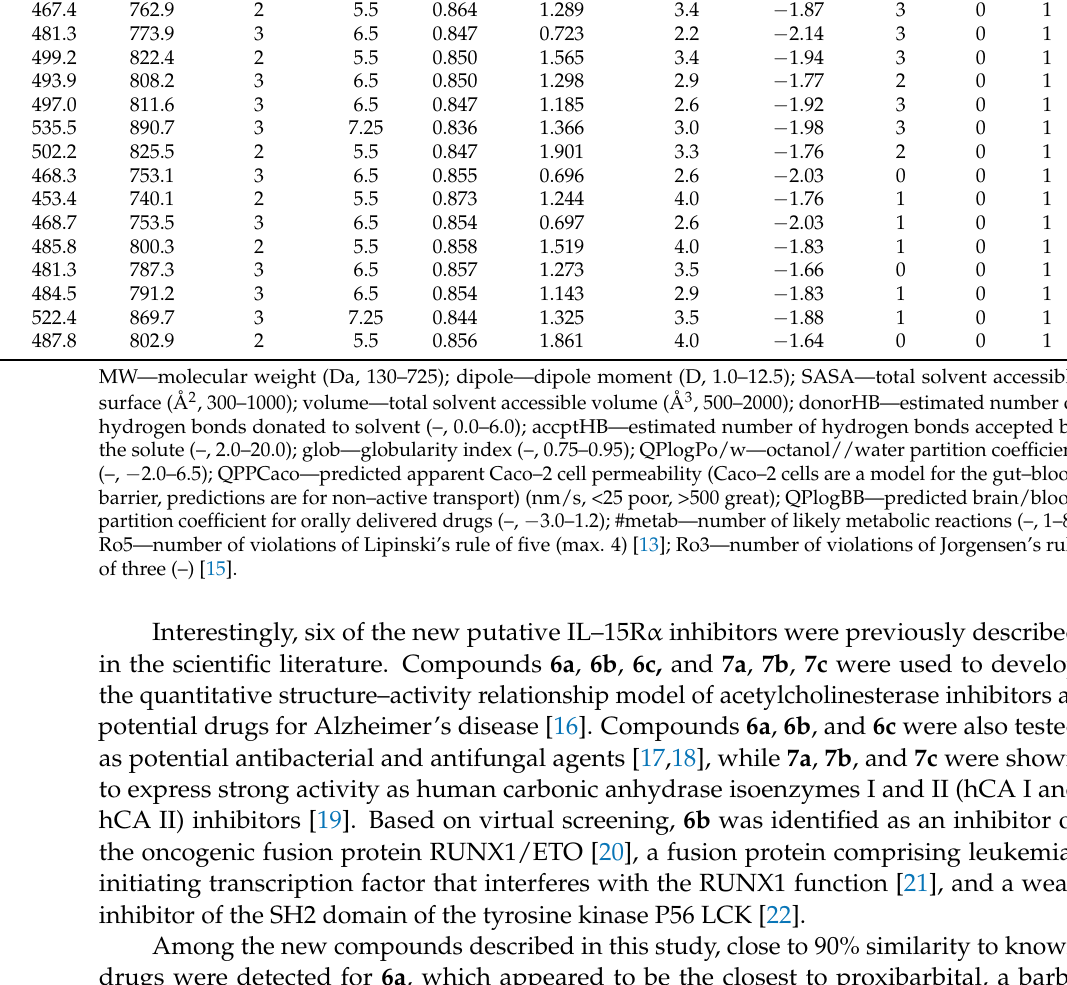
Table 3. Selected ADME properties of the new compounds (unit, range of descriptors values for 95% of known drugs). Values out of range are highlighted in red.